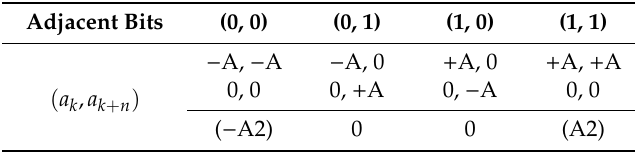
Table 3. Autocorrelation values for n =